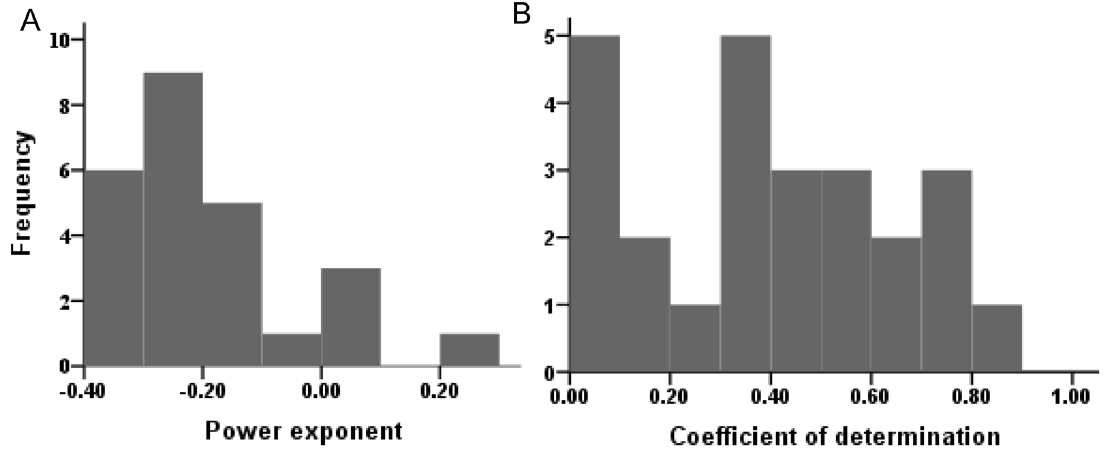
Figure 4. Regression parameters of power function. Power exponents (A) and coefficients of determination (B) for the relationship between sediment concentration and slope length for all